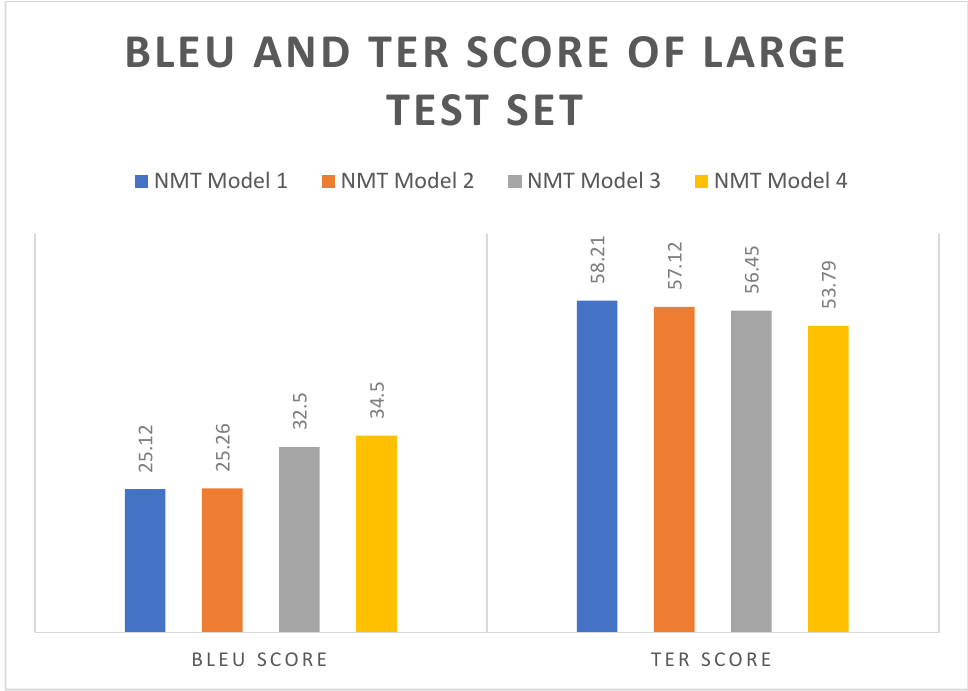
Figure 8. BLEU and TER scores of the large test set. Figure 8. Scores of BLEU and TER for the large test set.